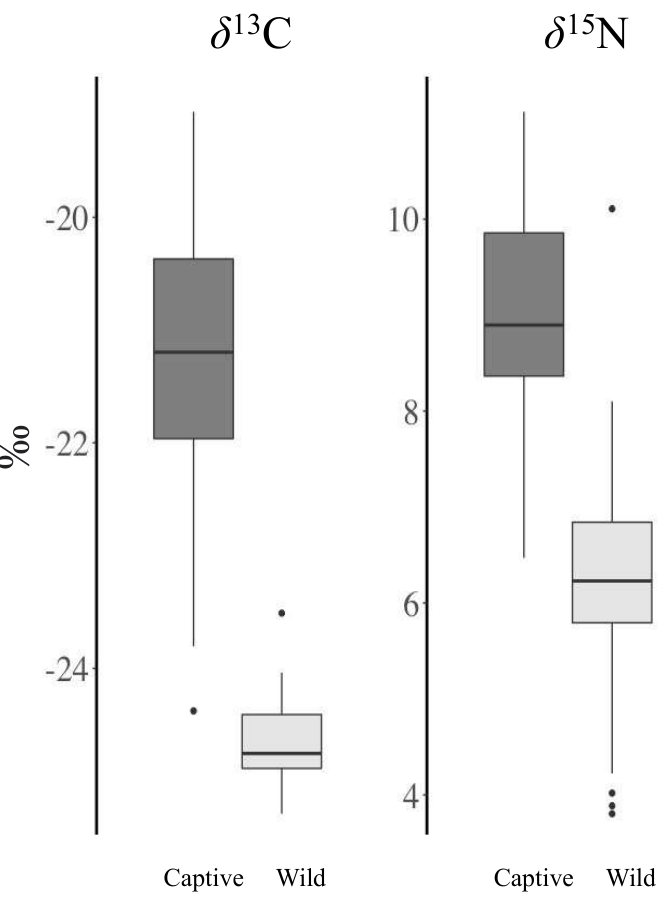
Figure 1. Carbon ( δ 13 C) and nitrogen ( δ 15 N) stable isotope values (per mil, ‰, measured by IRMS) derived from the claw tips of wild wood turtles captured in Maine and captive wood turtles sampled at various animal care facilities throughout the eastern United States (Table 1).